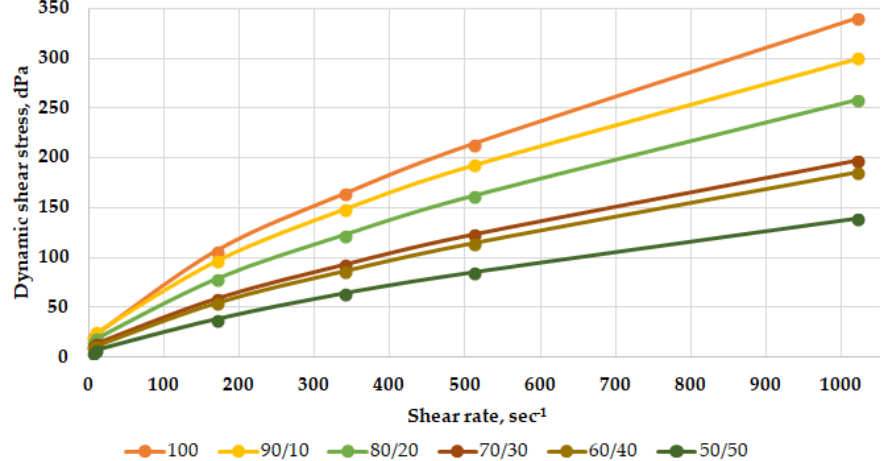
Figure 4. Rheological profiles of mixtures of heavy mud with brine depending on their ratio before heating under normal conditions.